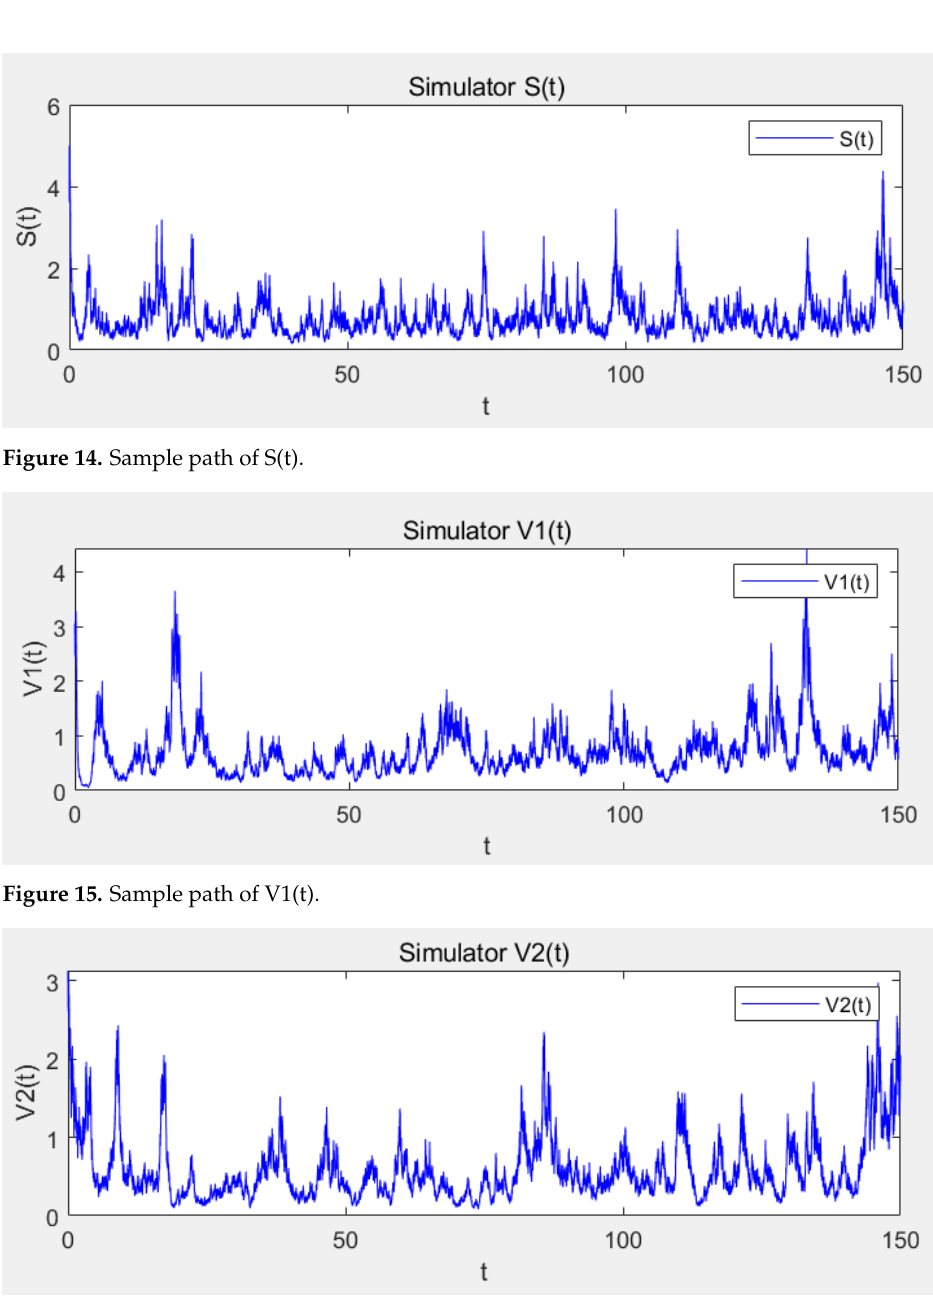
Figure 16. Sample path of